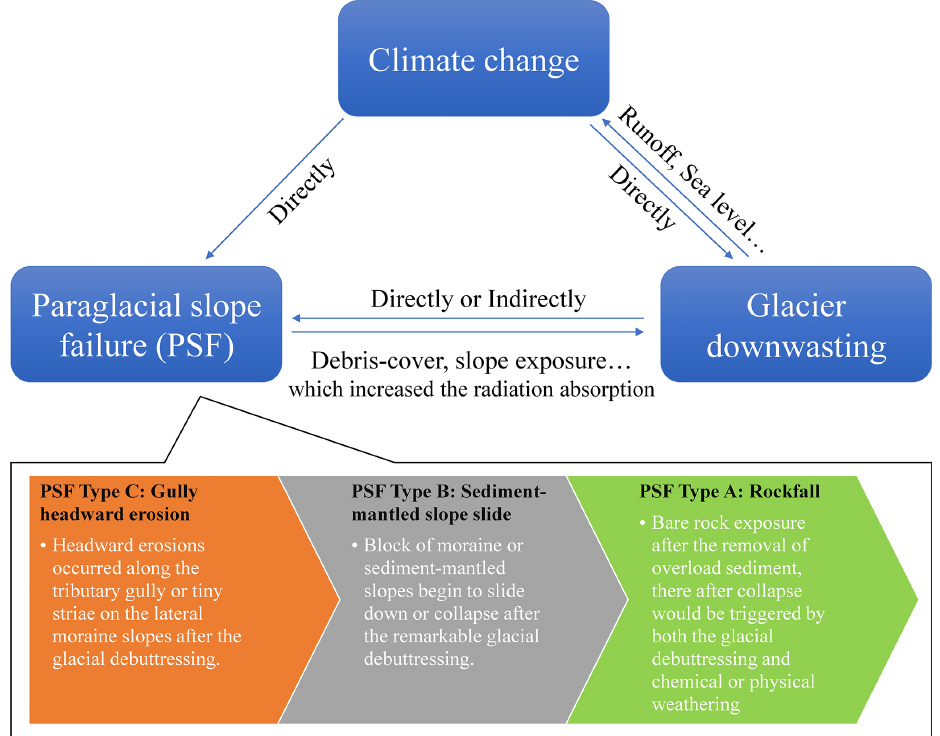
Figure 7. The relationship among PSF, ongoing climate change, and glacier downwasting. Climate change can directly trigger the PSF through extreme precipitation and sudden increase/decrease of temperature, or indirectly trigger the PSF by glacier downwasting, which can also be used as a preparatory factor to indirectly trigger PSF (e.g., rockfalls). At the same time, many debris fell into the glacier surface, increasing the range and thickness of the supraglacial debris cover, which in turn affected the surface energy balance for melting and therefore the downwasting rate of the glacier, which will thus influence the rate of runoff generation and its contribution to the sea level rise from glacierized catchments.